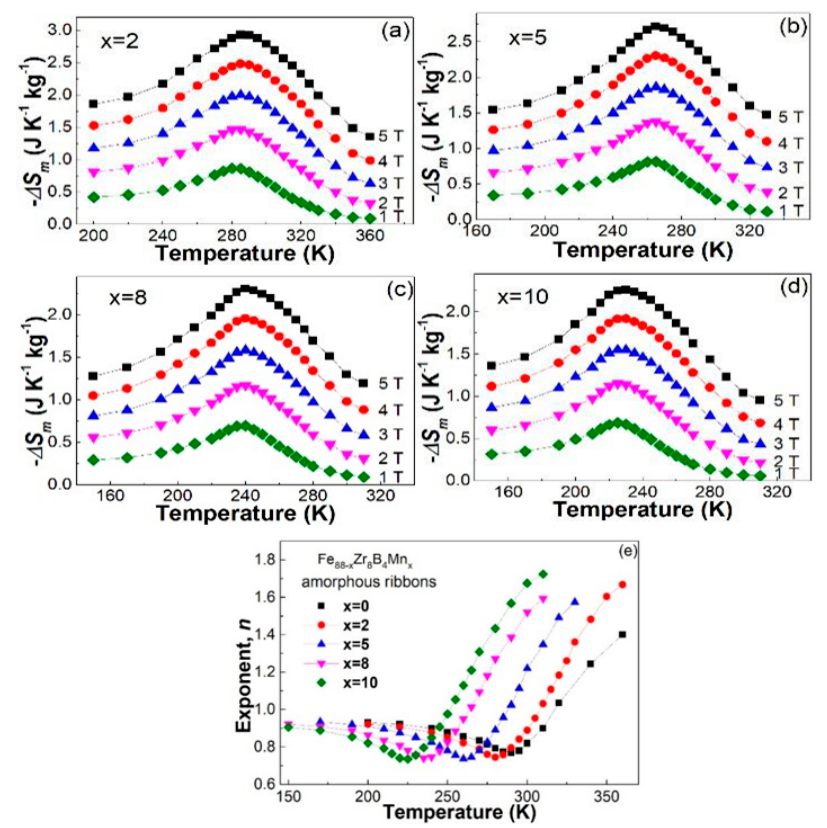
Figure 7. The −Δ S m -T curves of the amorphous Fe 88 − x Zr 8 B 4 Mn x samples from 1 to 5T: ( a ) for Fe 86 Zr 8 B 4 Mn 2 , ( b ) for Fe 83 Zr 8 B 4 Mn 5 , ( c ) for Fe 80 Zr 8 B 4 Mn 8 and ( d ) for Fe 78 Zr 8 B 4 Mn 10 ( e ) the n -T curves of the Fe 88 − x Zr 8 B 4 Mn x samples obtained by the −Δ S m ∝ H n relationship. Table 2. Magnetic and magnetocaloric properties of Fe 88-x Zr 8 B 4 Mn x amorphous samples.